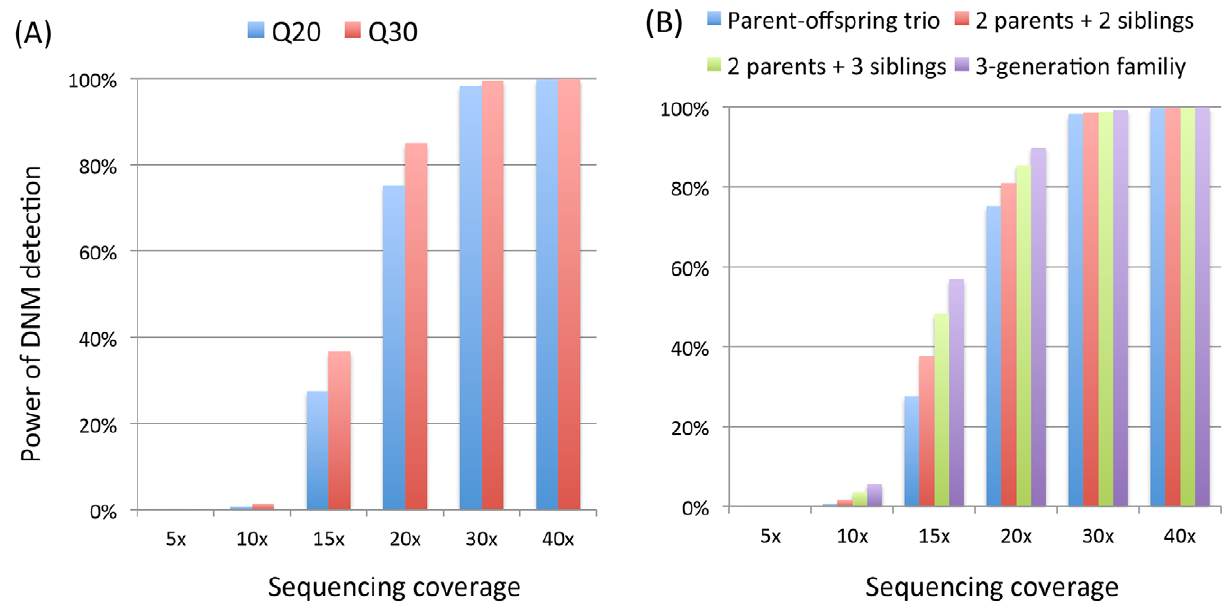
Figure 3. Power of detecting denovo mutations (DNM) in different pedigree structures for coverage from 5 6 to 40 6 . Panel A) shows the power for trios with base quality Q20 and Q30 and panel B) shows the power comparisons of trios, nuclear families with 2 and 3 siblings, and 3- generation extended pedigrees (shown in Figure 1) for base quality Q20 without mapping error.